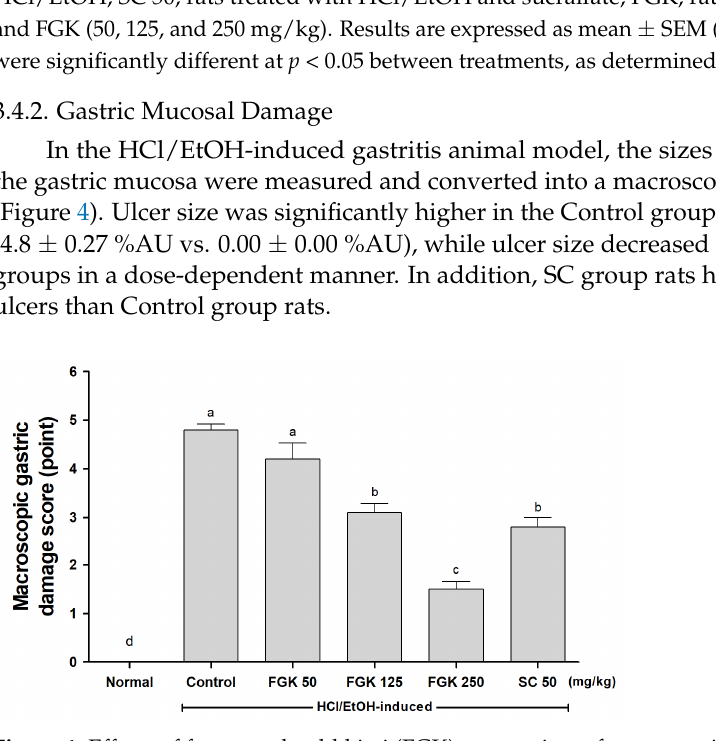
Figure 4. Effects of fermented gold kiwi (FGK) on gastric surface protection in HCl/EtOH-induced gastric injury models. Size of the ulcers that formed in the gastric mucosa was measured, and the sum of sizes was converted into a macroscopic damage score. Normal, rats treated with only DW; Control, rats treated with HCl/EtOH; SC 50, rats treated with HCl/EtOH and sucralfate; FGK, rats treated with HCl/EtOH and FGK (50, 125, and 250 mg/kg). Results are expressed as mean ± SEM (N = 8). a–d Different labels were significantly different at p < 0.05 between treatments, as determined by Tukey’s analysis.